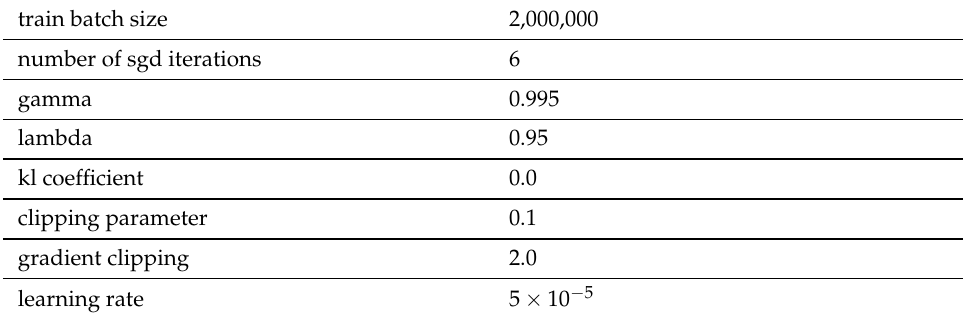
Table 1. Parameters of the PPO algorithm used in all experiments.